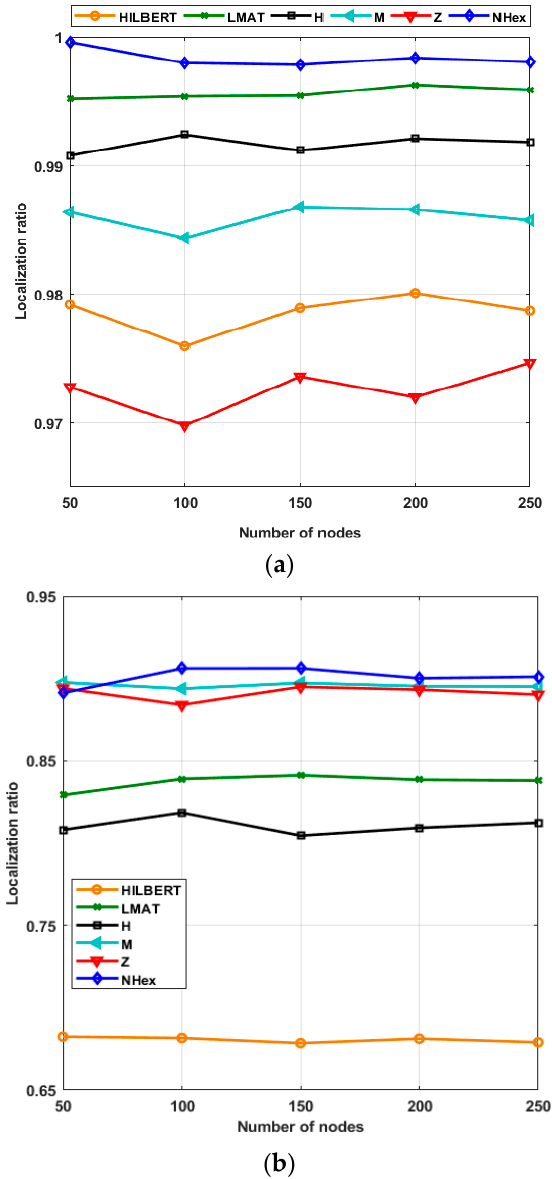
Figure 18. Scalability of the path planning models in terms of localization ratio performance ( a ) WCL, and ( b ) APT.